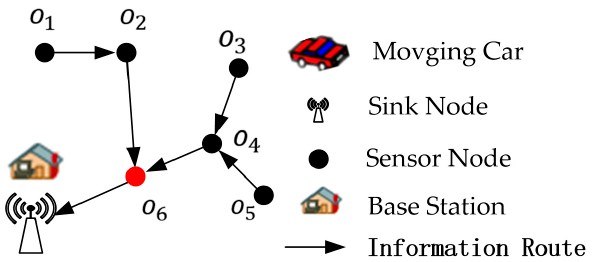
Figure 3. The data routing path to the Sink in the data collection network.